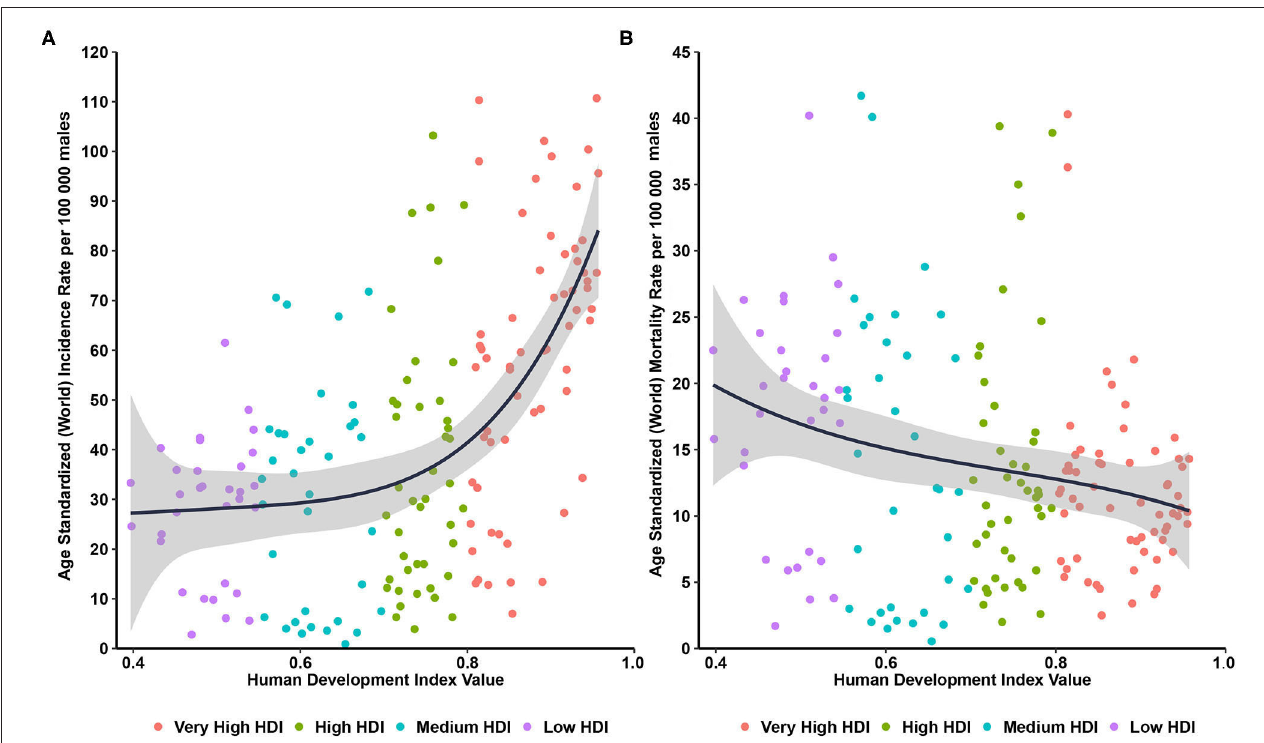
FIGURE 2 | Correlations between age-standardized incidence and mortality of prostate cancer and human development index. (A) age-standardized incidence rate; (B) age-standardized mortality rate.